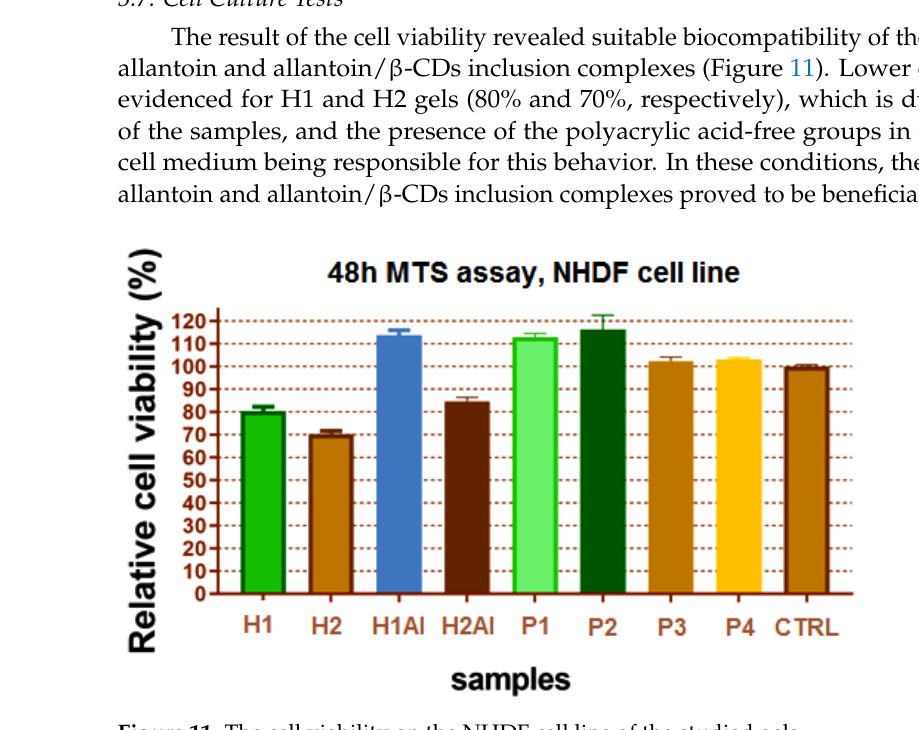
Figure 11. The cell viability on the NHDF cell line of the studied gels.